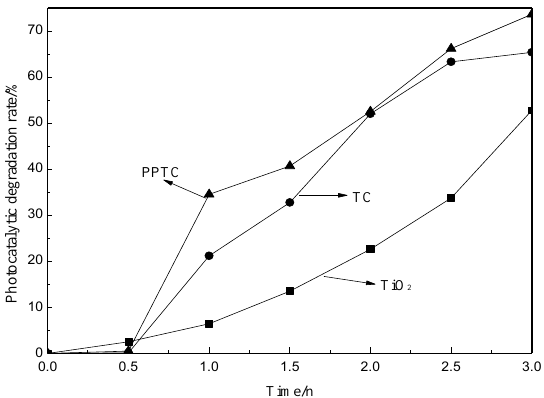
Figure6. PhotocatalyticperformanceofTiO 2 ,TC,andPPTCtowarddegradationof N , N -dimethylformamide Figure 6. Photocatalytic performance of TiO 2 , TC, and PPTC toward degradation of N , N - dimethylformamide (DMF).